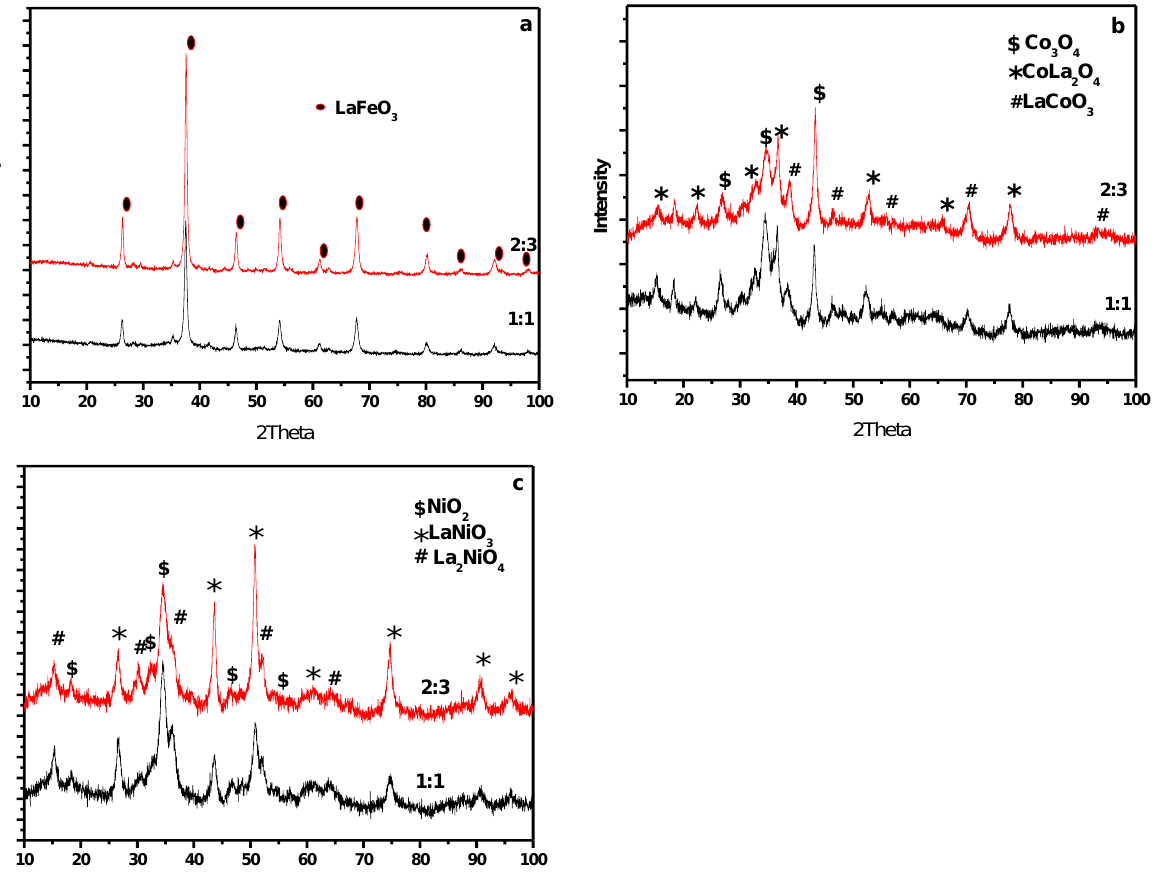
Figure 1. XRD patterns of the La composites calcined at 540 °C. ( a ) LaFeO 3 , ( b ) LaCoO 3 and ( c ) LaNiO 3 .